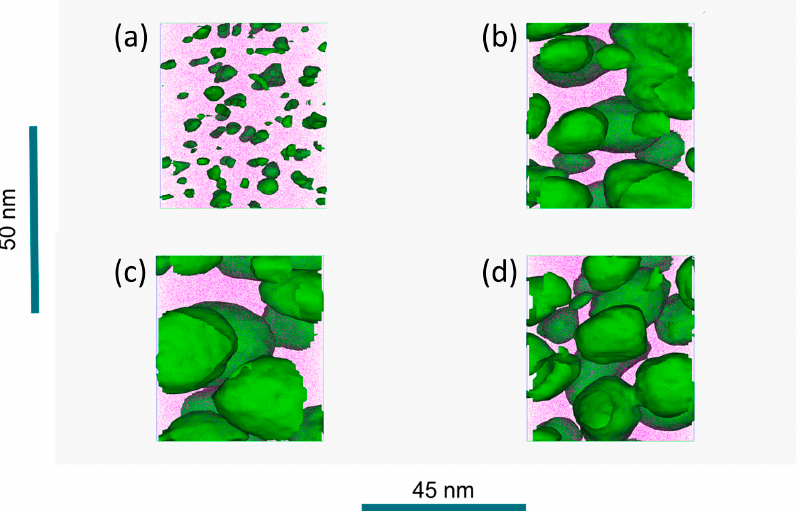
Figure 3. APT reconstruction of a measured volume in WQ state ( a ), 10 h ( b ), 30 h ( c ), and 50 h ( d ) aged state (all after homogenization and annealing). Small (approximately 3 nm sized) Ni and Ti-rich precipitates in the main present matrix phase can already be seen in the WQ state, γ ’ precipitates of average size between 11 and 15 nm can be observed in the aged states. Matrix channels with approximately 10–30 nm width can be seen between the precipitates in the aged states.